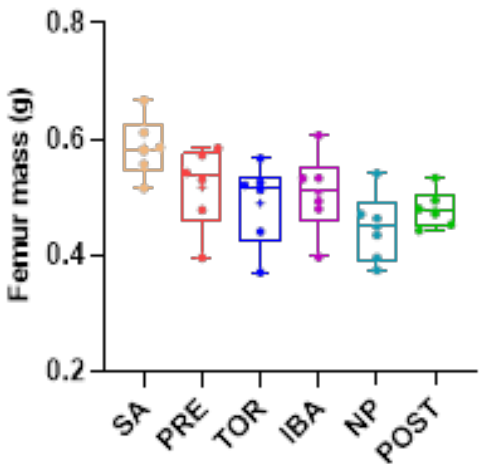
Figure 2. Comparison of femur mass in Daurian ground squirrels in different groups. Boxes represent upper and lower quartiles, middle horizontal line represents median, plus sign represents average, lines extending from upper and lower ends represent upper and lower edges, respectively, and points represent individual sample values ( n = 6). No superscript letters denote no significant differences among groups by Sidak test ( p > 0.05). SA, summer active group; PRE, pre-hibernation group; TOR, torpor group; IBA, interbout arousal group; NP, near post-hibernation group; and POST, post-hibernation group.